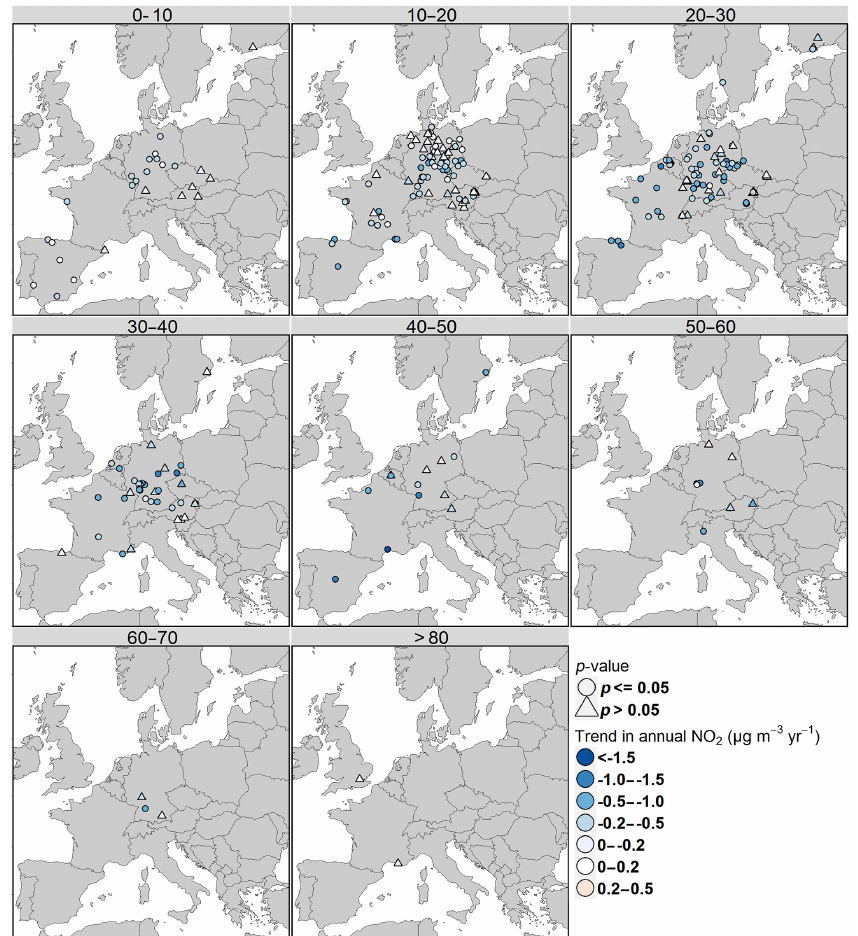
Figure 9. Magnitude and significance of trend in annual average NO 2 concentrations between 2000 and 2014, with sites separated into panels based on 2010–2014 average annual NO 2 concentrations (NO 2AA ). The colour in each point denotes the magnitude and direction of the Theil–Sen trend at a site, and the outer colour denotes whether the trend was statistically significant ( p ≤ 0.05, circle), or not statistically significant ( p >0.05, triangle). Trend estimates were calculated using a first-order autoregressive (AR(1))